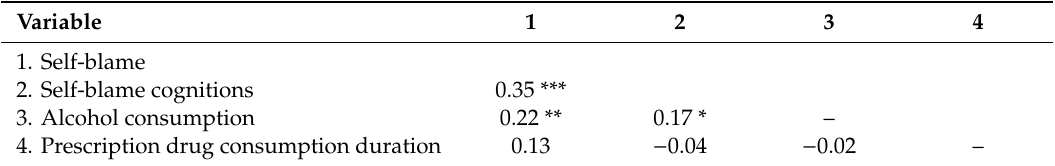
Table 3. Correlations of Study 2.